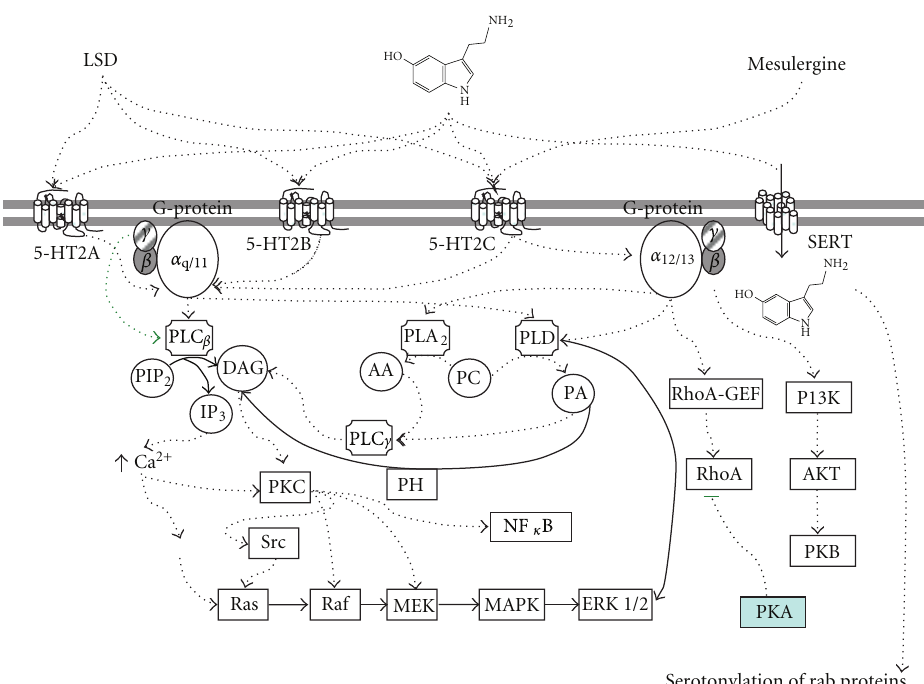
Figure 5: 5-HT 2 receptors signaling. Main pathways of intracellular signaling for these serotonine receptors subtype involve rupture of membrane phospholipids, particularly with phospholipase C (PLC) producing diacylglycerol (DAG) and inositol 1,4,5-trisphosphate (IP 3 ) from phosphatidylinositol 4,5-bisphosphate (PIP 2 ). These second messengers activate protein kinase C (PKC) which in time may activate the extracellular signal-regulated kinases 1 and 2 (ERK1/2) [50]. Phospholipase A2 is eventually activated producing arachidonic acid (AA) from phosphatidylcholine (PC), or phosphatidic acid (PA) by means of phospholipase D (PLD) [44, 50]. SERT is included in the diagram, coexisting in astrocytes for example, to emphasize the intracellular participation of serotonin itself [14]. Other pathways including (Rho- GEF) and (PI3K) are shown [51]. MEK, mitogen-activated protein kinase; PH, phosphohydrolase enzyme; PKA, protein kinase A-relation to cAMP pathways; SERT, serotonin